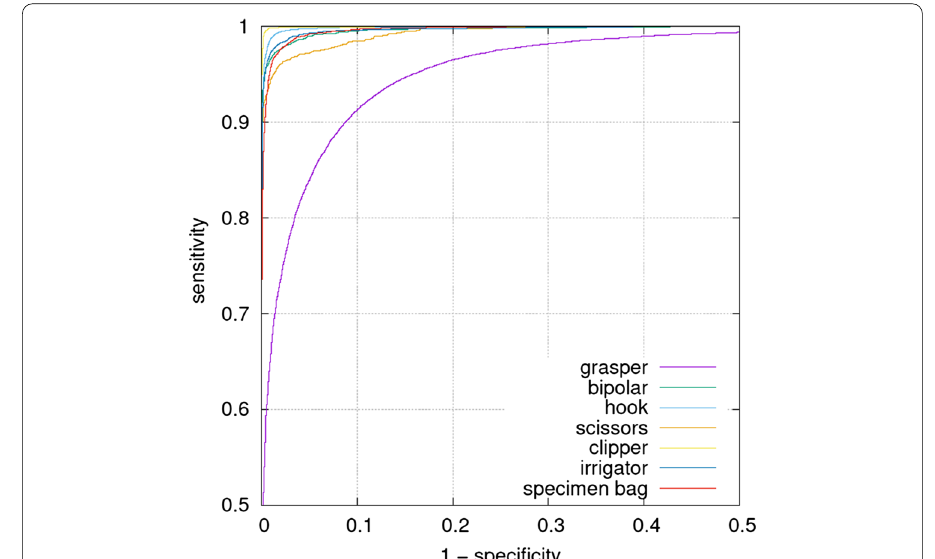
Fig. 11 Receiver-operating characteristic (ROC) curves for the best classifier